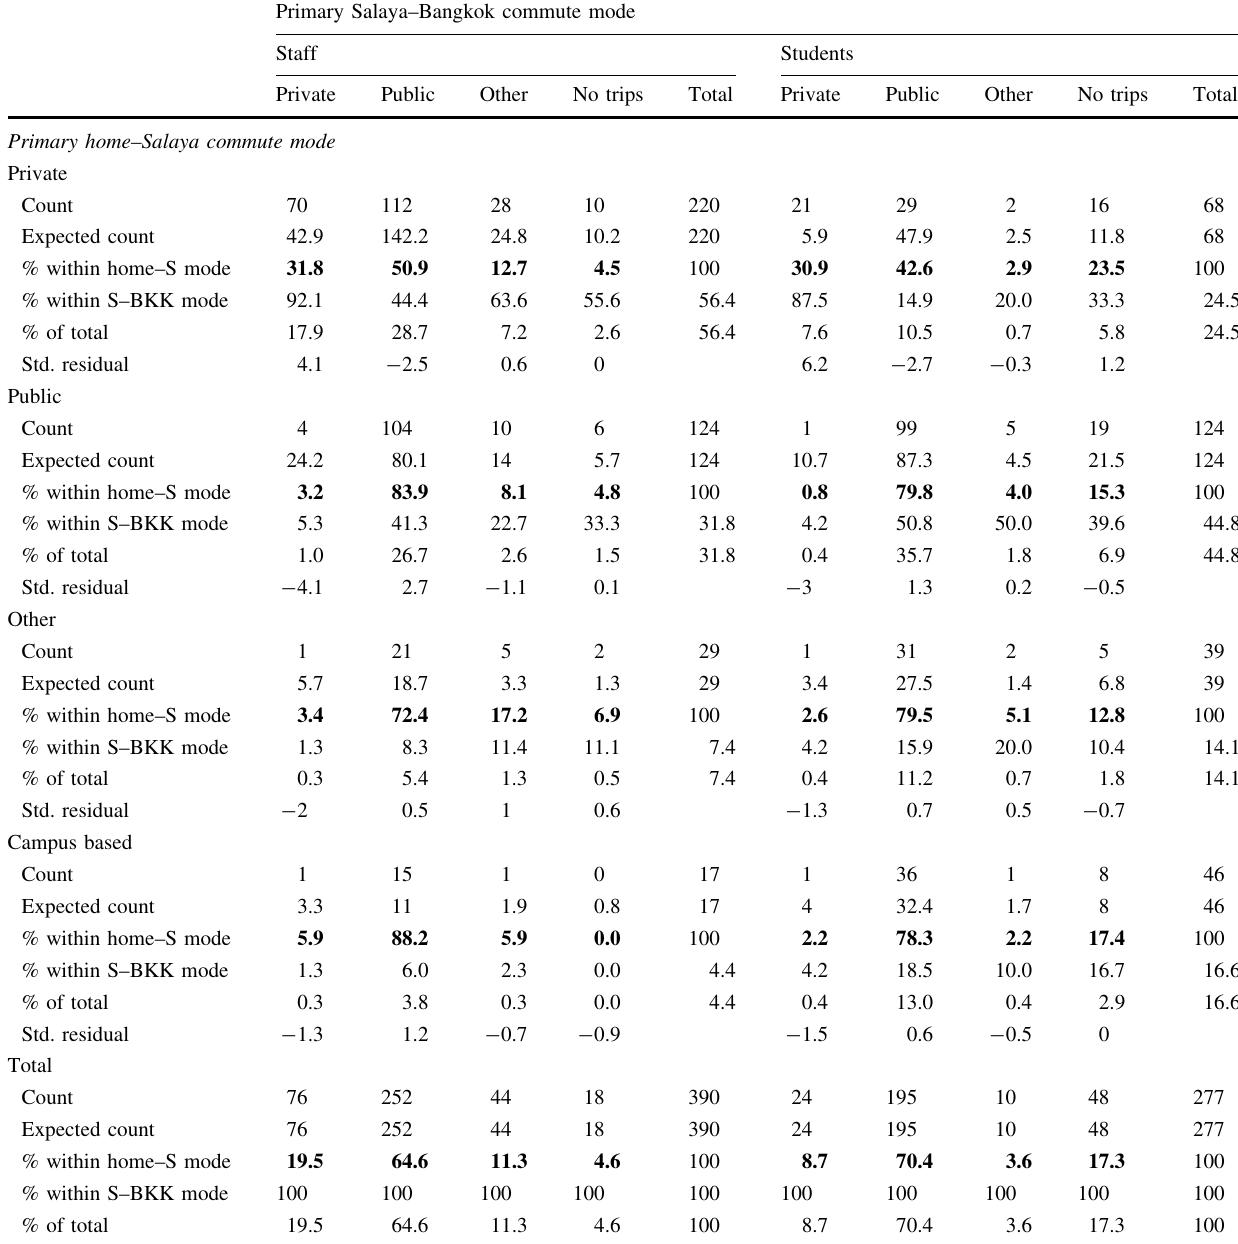
Table 2 Respondents’ primary transport mode for home–Salaya versus Salaya–Bangkok commute